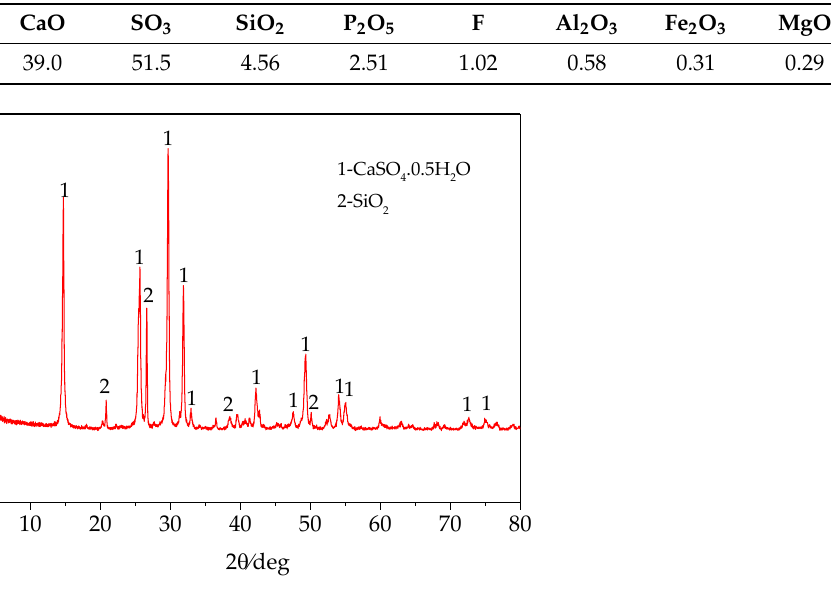
Figure 1. XRD test results of phosphogypsum.